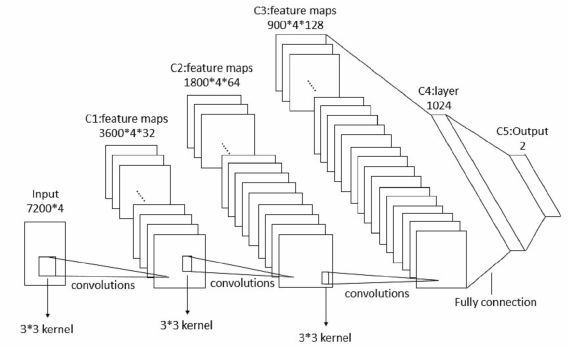
Figure 2. The architecture of convolutional neural network